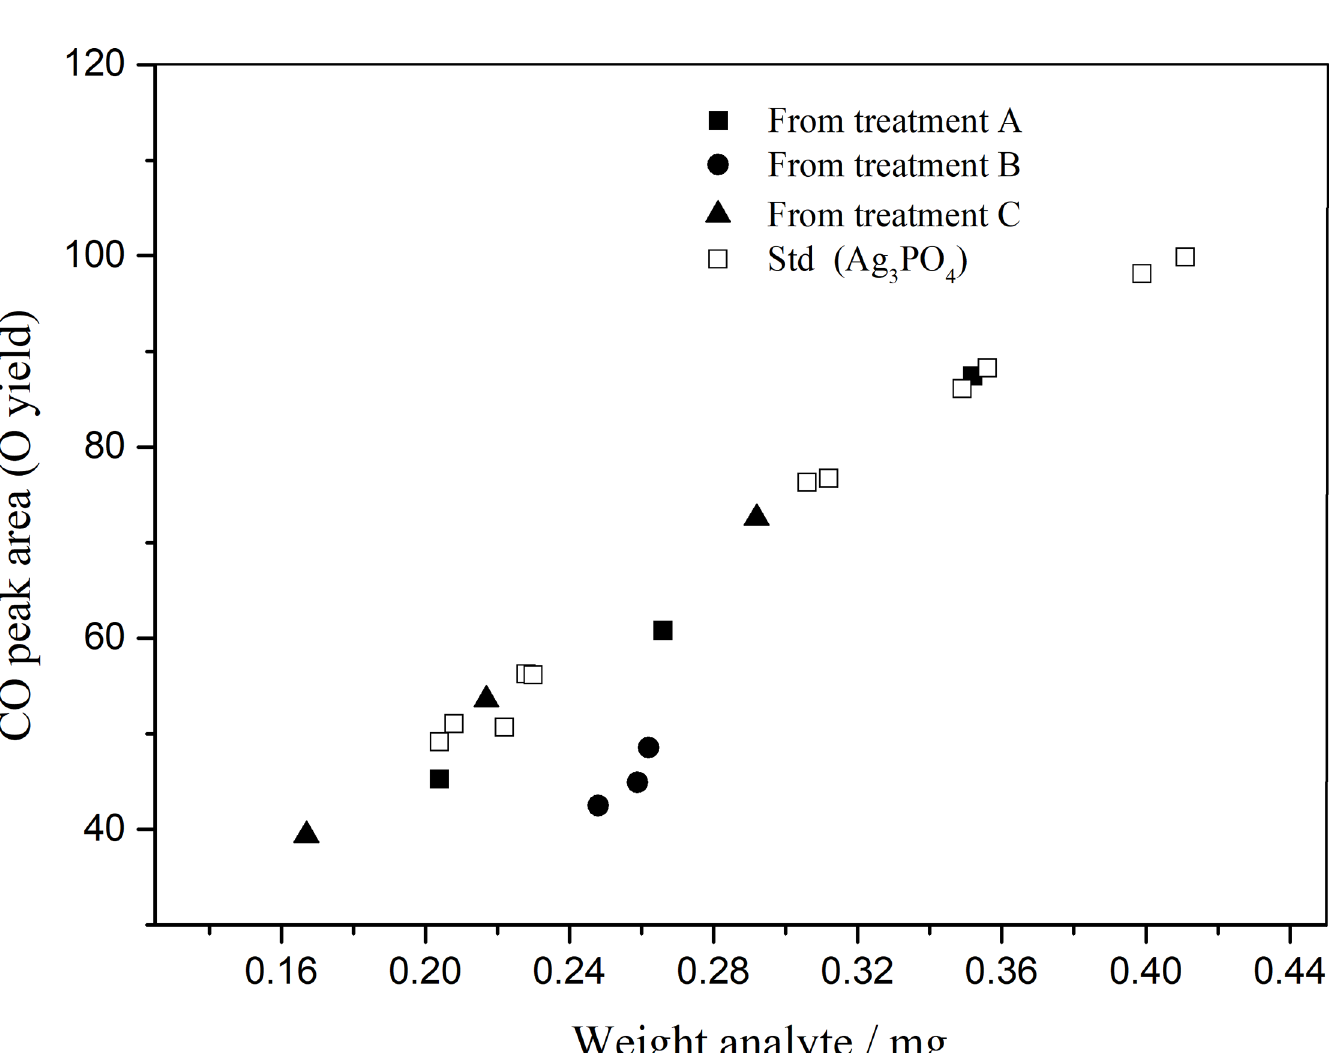
Fig 4. Weight of analyte plotted against the area of the CO peak for the prepared silver phosphate treated by each treatment.